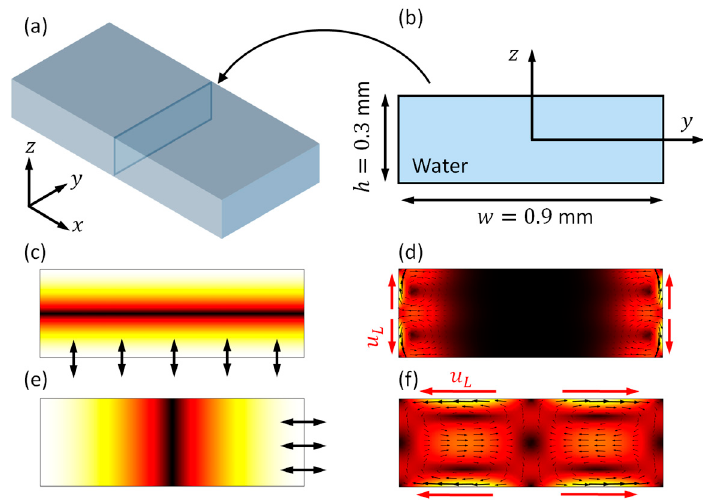
Figure 2. Numerical simulations of boundary-driven acoustic streaming fields in a fluid channel with rectangular cross-sections. ( a ) A typical three-dimensional (3D) rectangular fluid channel (where fluid goes in the x direction); ( b ) a two-dimensional (2D) reduced-fluid model representing a cross-section of ( a ); ( c ) a vertical half-wavelength standing wave field, generated by a harmonic vibration of the bottom boundary at f = 2.469 MHz; ( d ) the outer streaming field for mode ( c ); ( e ) a lateral half-wavelength standing wave, generated by a harmonic vibration of the right boundary at f = 0.823 MHz; and, ( f ) the corresponding outer streaming field in mode ( e ). Colors in ( c – f ) represent magnitudes (white for maximum and black for zero). u L is the limiting